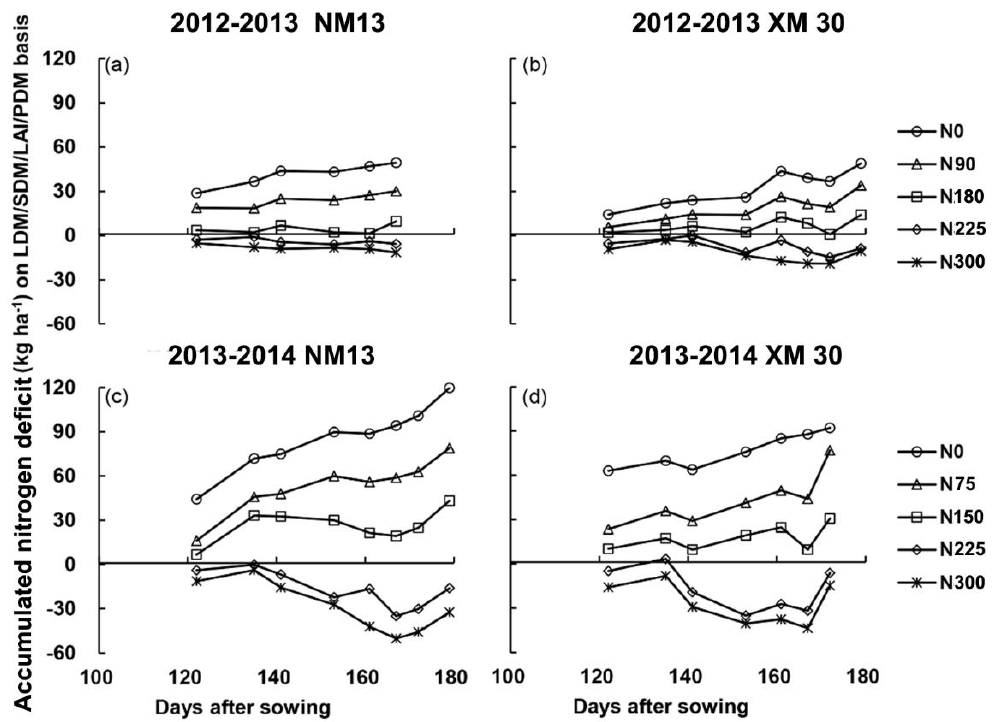
Figure 5. Accumulated N deficit (AND) (kg ha − 1 ) of wheat at di ff erent growth stages on the basis of di ff erent critical N dilution curves ( a ): leaf dry matter basis; ( b ): stem dry matter basis; ( c ): plant dry matter basis; ( d ): leaf area index basis.